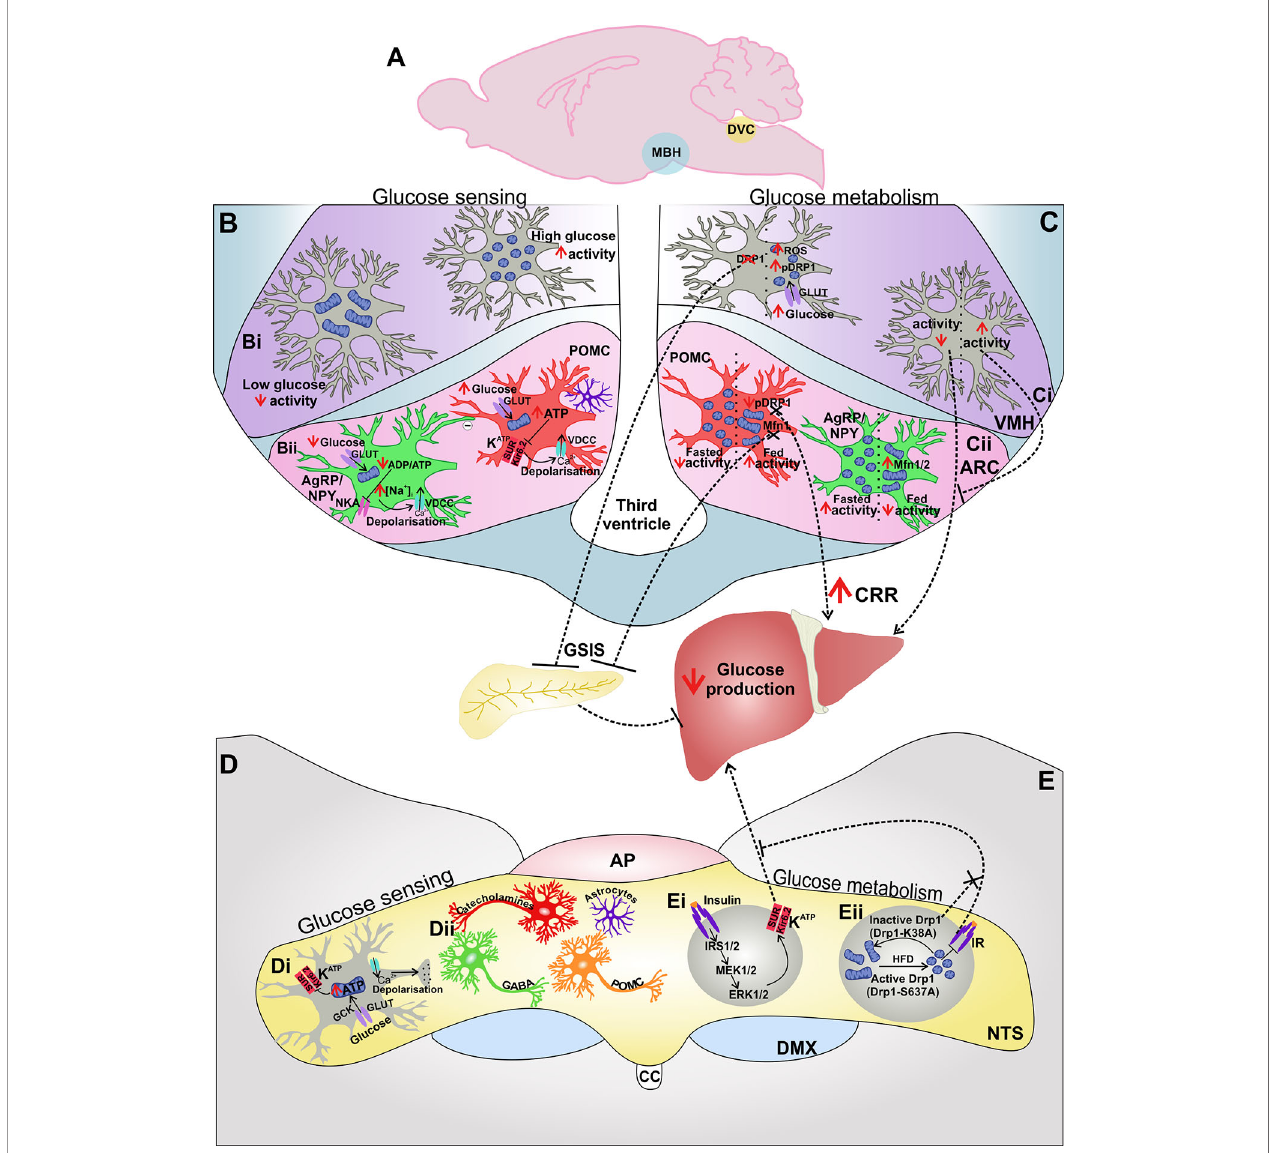
FIGURE 2 | The MBH and DVC are involved in central glucose sensing and control of glucose metabolism: The MBH and DVC are distinct areas which are involved in both glucose sensing and glucose metabolism (A) . Glucose sensing cells in the MBH (B) are present in both the VMH (Bi) and ARC (Bii) . In the VMH increased glucose leads to mitochondrial fi ssion and increased neuronal activity (Bii) . In the ARC, glucose-inhibited (GI) AgRP and glucose-excited (GE) POMC neurons utilize the Na + /K + -ATPase (NKA) or K ATP channels in order to couple extracellular glucose levels and energy status with neuronal activity (Bii) . Astrocytes also in fl uence the activity of POMC neurons in response to changes in glucose availability (Bii) . The MBH also in fl uences glucose metabolism (C) , where neuronal activity and increased mitochondrial fi ssion and neuronal activity in VMH neurons induce glucose-stimulated insulin secretion (GSIS) from the pancreas and decrease glucose production (Ci) . Mitochondrial dynamics in AgRP and POMC neurons in the ARC in fl uence neuronal activity of these neurons in response to fasted vs fed states (Cii) . Inhibition of mitochondrial fusion in POMC neurons inhibits GSIS (Cii) . The DVC is also able to sense glucose (D) , utilizing KATP channels to transduce changes in extracellular glucose levels and therefore energy availability to neuronal activity (Di) . Various cells have been implicated in glucose sensing in the DVC, including catecholaminergic-, GABAergic-, POMC neurons, and astrocytes (Dii) . The DVC also in fl uences glucose metabolism (E) by insulin signaling mediated ERK1/2 activation of K ATP which decreases glucose production (Ei) . Mitochondrial fi ssion inhibits insulin receptor signaling in the DVC and impairs DVC control of glucose homeostasis by inhibiting reduced HGP (Eii) . Abbreviations: CRR, counter-regulatory response; GCK, glucokinase; GLUT, glucose